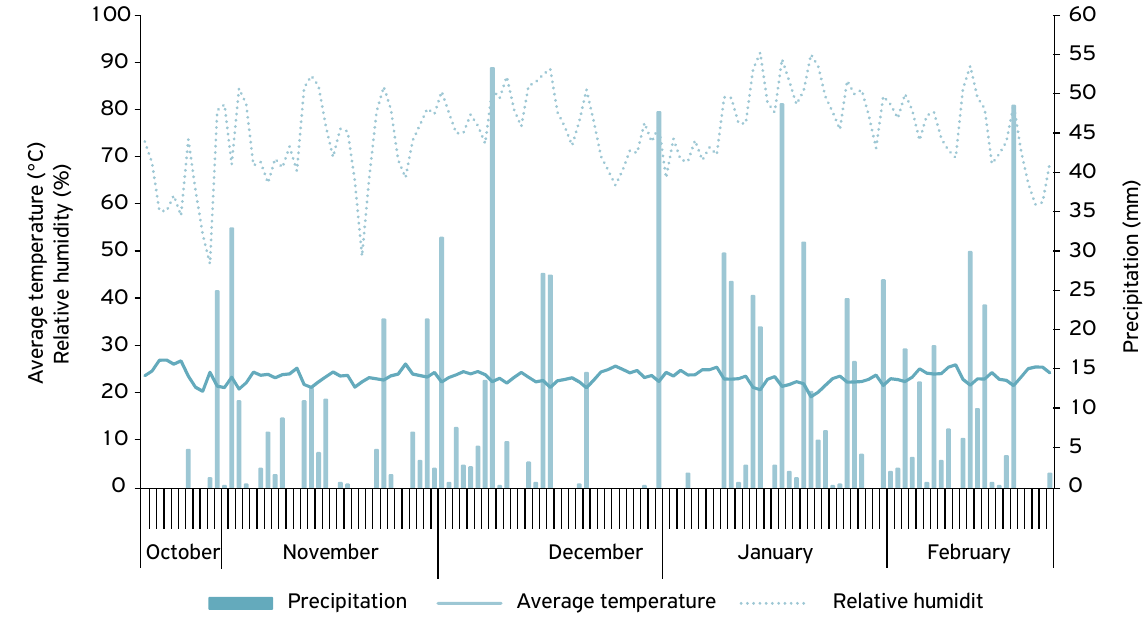
Figure 1. Average air temperature, relative air humidity, and total daily precipitation during the experimental period.